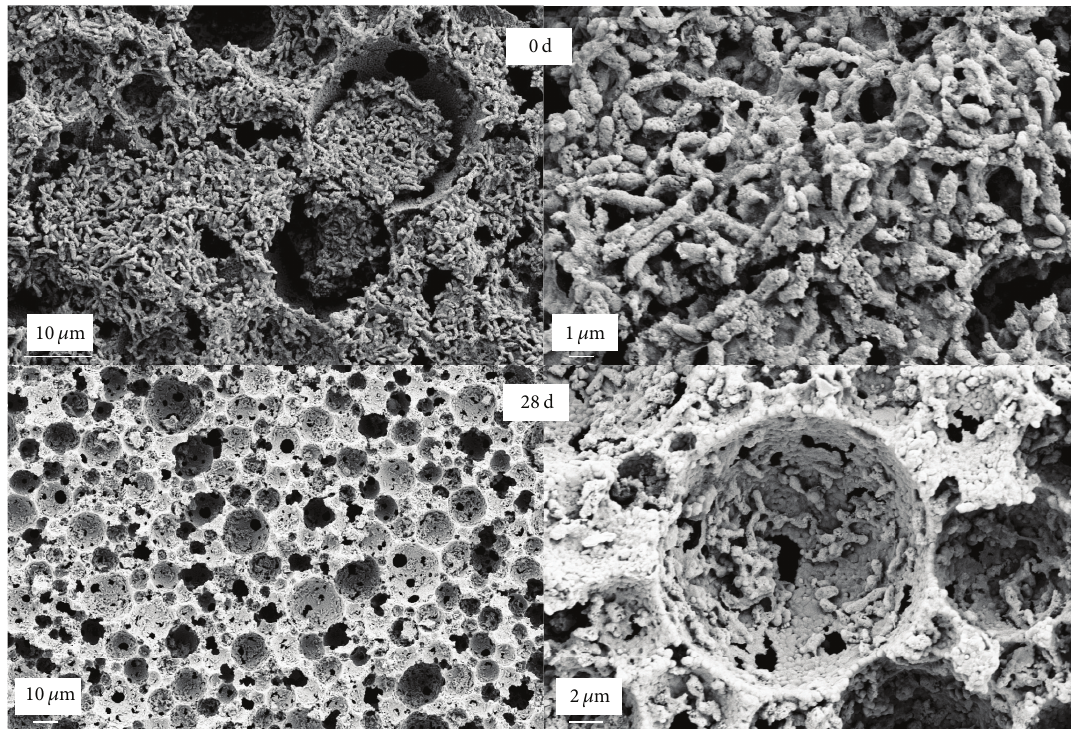
Figure 7: P. sp. strain MLms gA3 biofilm on the ceramic tile after 0 and 28 days of incubation in sterilised artificial seawater. Compared to day 0, in which a clear biofilm was detected on the ceramic tile, there were only single cell aggregates found on the ceramic tile after 28 days of